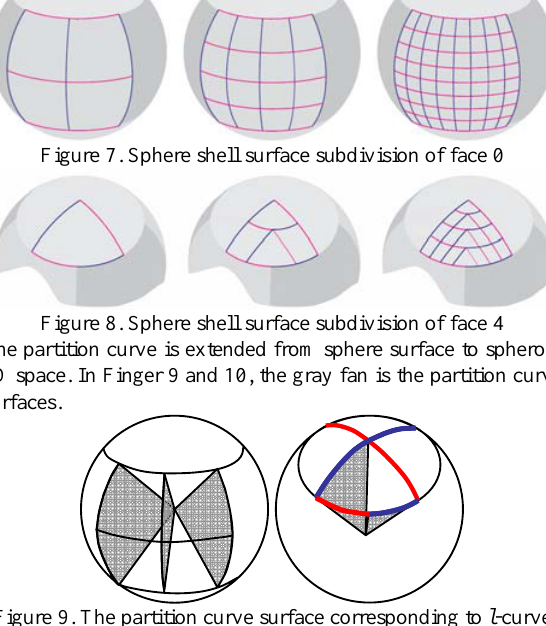
Figure 5. Sphere shell space geometric structure.